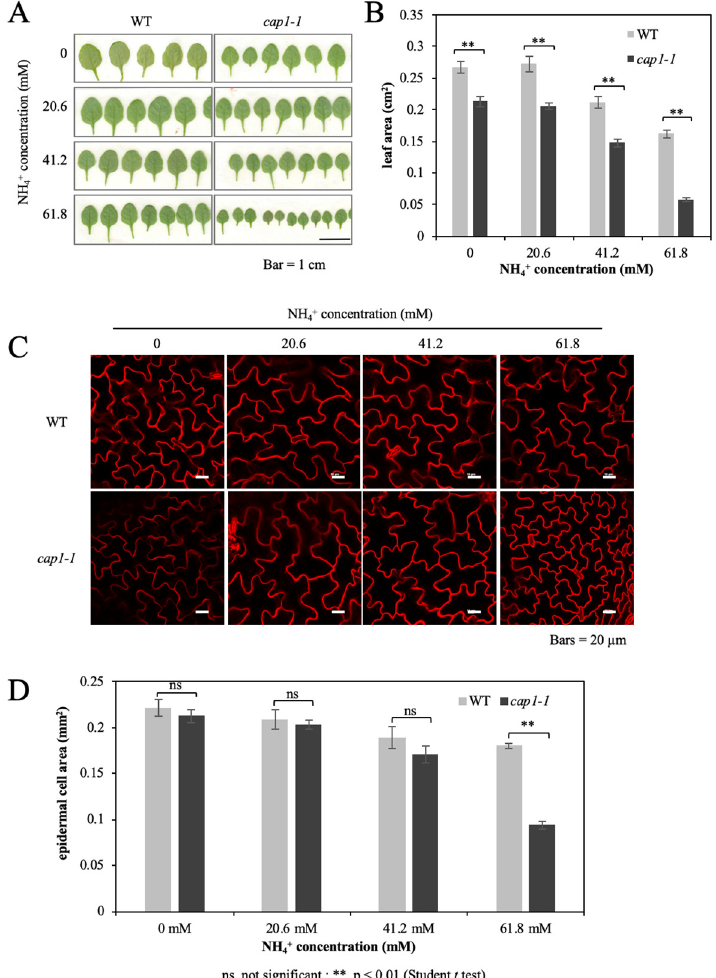
Figure 2. Leaf area and cell size of WT and cap1-1 plants under different growth concentrations. ( A ) The 3rd leaf phenotype and ( B ) leaf area in WT and cap1-1 plants grown on 4 different media with 0, 20.6, 41.2, and 61.8 mM NH 4+ . ( C ) The epidermis of the 3rd leaf was stained with FM4-64 and scanned by a confocal microscope. ( D ) Epidermal cell area of the 3rd leaf under MS medium without ammonium (0 mM NH 4+ ), MS medium (20.6 mM NH 4+ ), and MS medium with 41.2 or 61.8 mM NH 4+ treatment. Seven-day-old seedlings were transplanted to a pot containing only vermiculite. Solutions containing 0, 20.6, 41.2, and 61.8 mM NHCl 4 were applied to the respective plants for about 4 weeks. Values are the means ± SE, n = 8–11. (Independent samples t -test; ns, not significant; **, p < 0.01.)